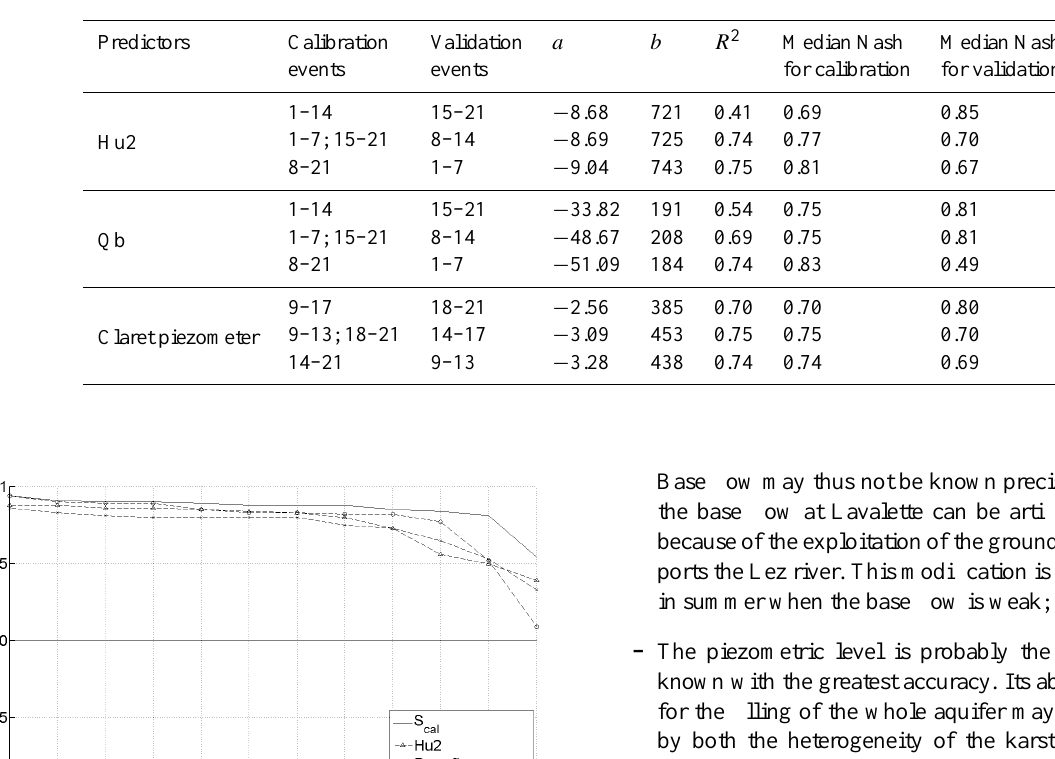
Table 6. Results of the split sample tests performed with the three predictors (Hu2 index, base flow Q b and Claret piezometric level). “ a ”, “ b ” and “ R 2 ” are respectively the slope, the intercept and the determination coefficient of the regression established between the initial condition S and the given predictor using the events of the calibration sample.